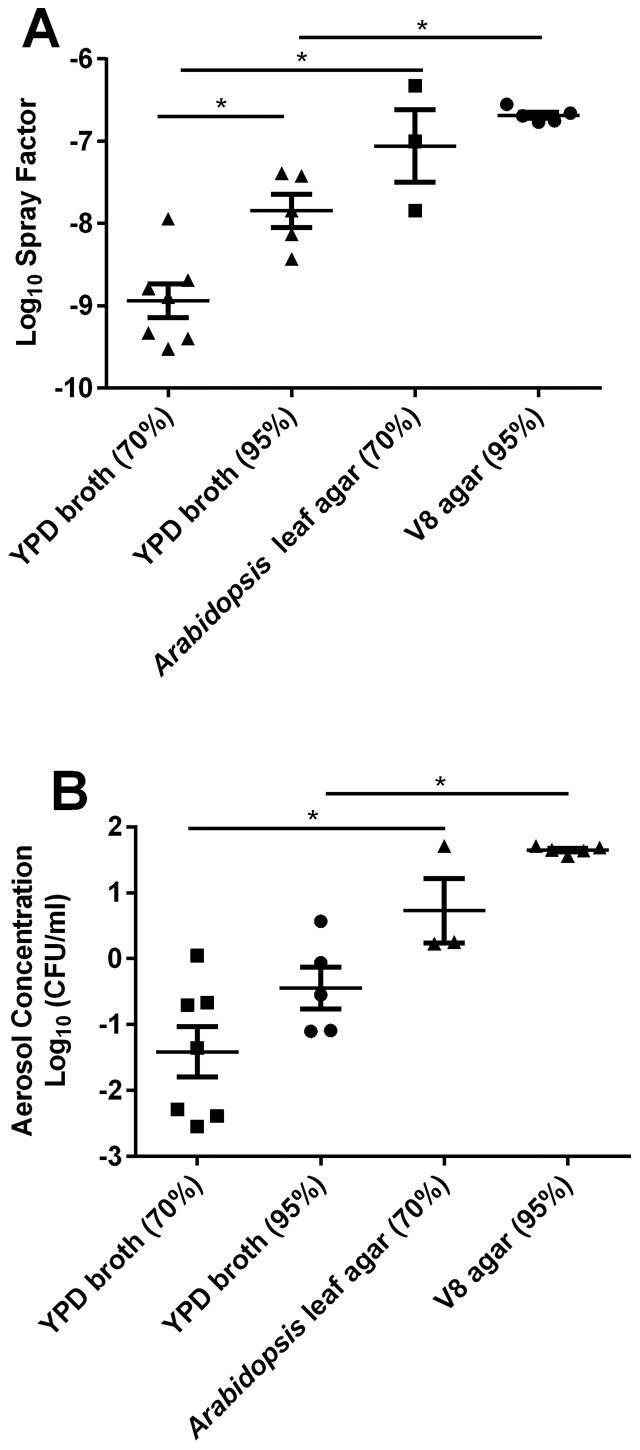
Growth on agar increases spray factor and viable aerosols for Cryptococcus during aerosolization in the Madison Chamber.(A) Log spray factor of C. neoformans var. grubii (H99) and C. gattii (EJB18) plotted in respect to growth condition and relative humidity. High humidity increases spray factor for broth-grown cells. (B) Log aerosol concentration of C. neoformans var. grubii (H99) and C. gattii (EJB18) plotted in respect to growth condition and relative humidity. Growth on agar increased log aerosol concentrations. Triangle, square, or circles represent growth conditions denoted in the x-axis for each individual exposure Mean values (n = 3–7, +/− SEM) are plotted. * indicates p<0.01.